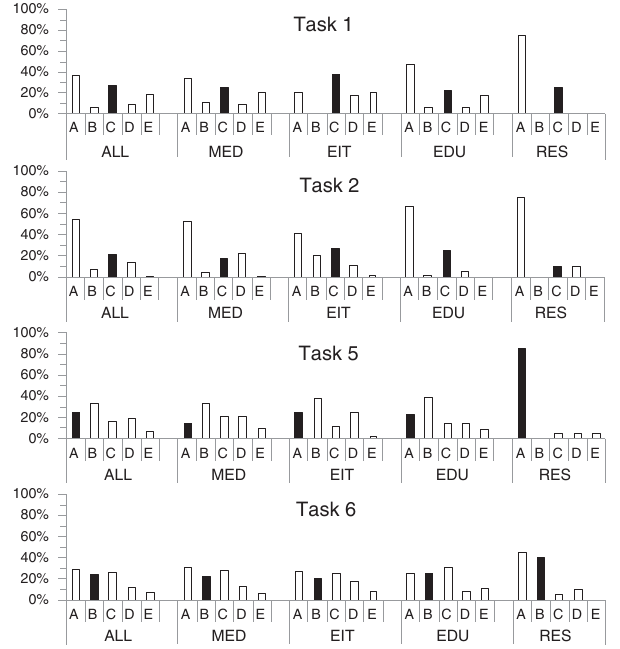
FIG. 1. The students ’ responses to the concept inventory multiple choice (A – E) questions (Tasks 1, 2, 5, and 6), grouped by the gas structure concept concerned. Results for each question are presented by five bar diagrams, each containing the total sample ( N ¼ 250 ) result ALL and the results from all the test groups (MED, EIT, EDU, and RES). The correct answers are presented by the black